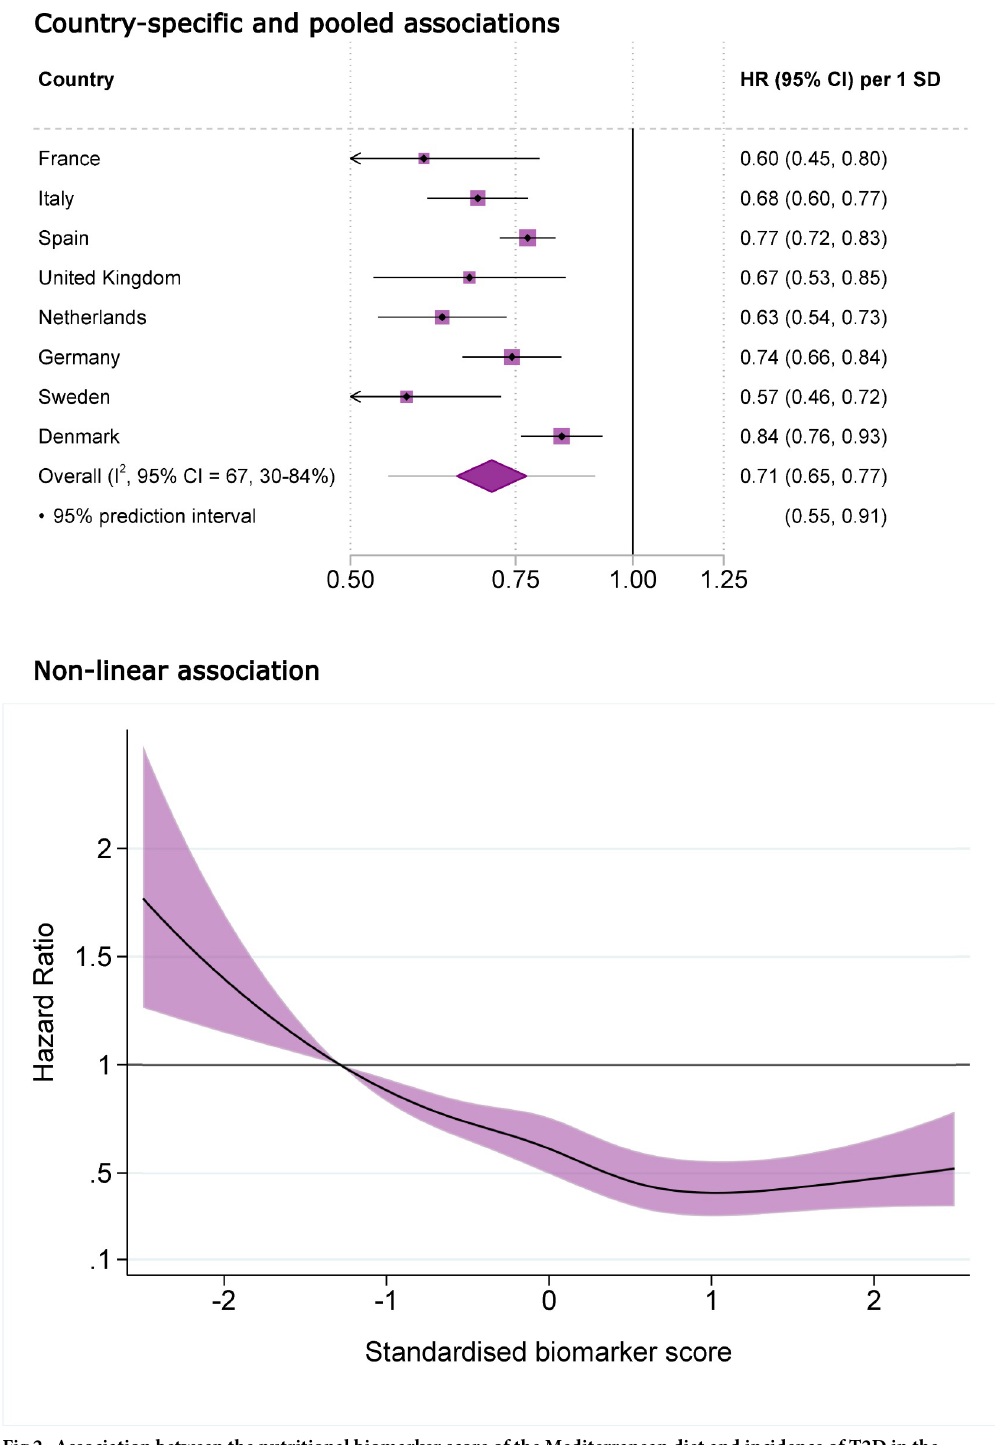
Fig 2. Association between the nutritional biomarker score of the Mediterranean diet and incidence of T2D in the EPIC-InterAct case-cohort study ( n = 22,202). The biomarker score was derived as a discriminatory model between the Mediterranean and habitual diet in the MedLey randomised partial-feeding controlled trial. Circulating carotenoids and fatty acids were used to calculate the score as linear predictions from the discriminatory model. Associations were assessed with the Prentice-weighted Cox regression and pooled by random-effects meta-analysis. Top: The diamond and error bars of the pooled estimate represent the 95% confidence and prediction intervals. Bottom: Restricted cubic splines with 5 knots